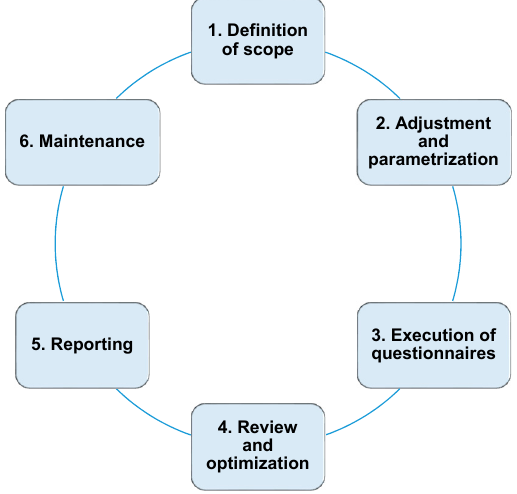
Figure 3. OpRSA Process. Source: author own study.